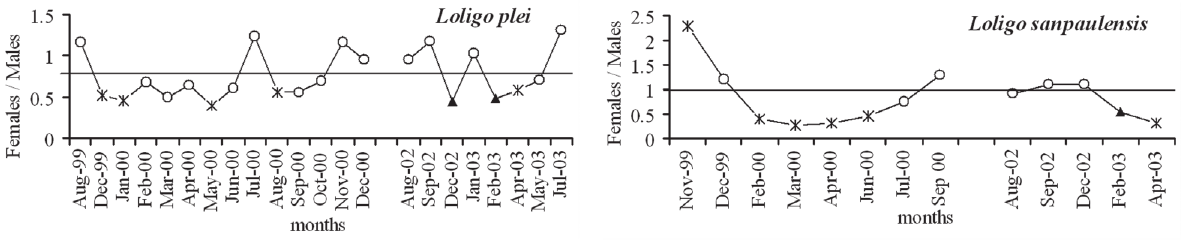
Fig. 9 . – Monthly variation of the sex-ratio in samples of (a) L. plei and (b) L. sanpaulensis . ( ö ) sex-ratio 1:1; ( ‹ ) mature predominance (> 60%) and ( p ) immature predominance (>